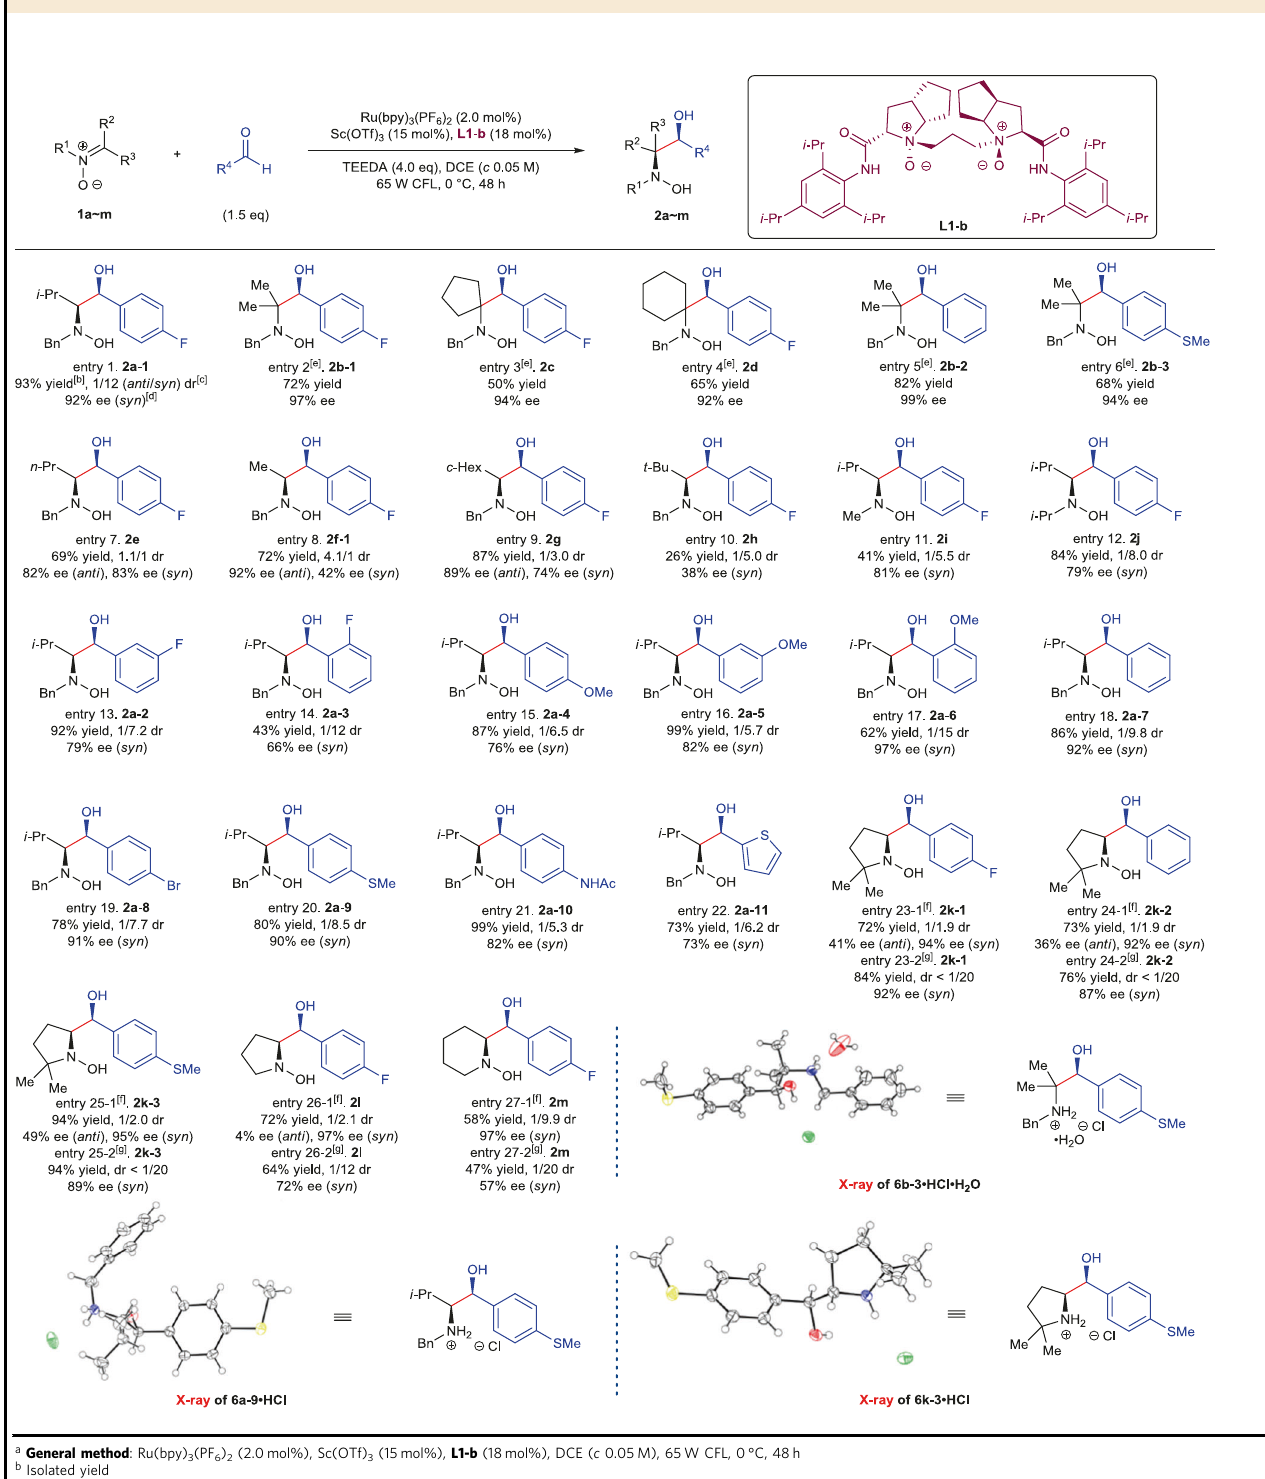
Table 2 Enantioselective reductive cross-coupling of nitrones with aldehydes